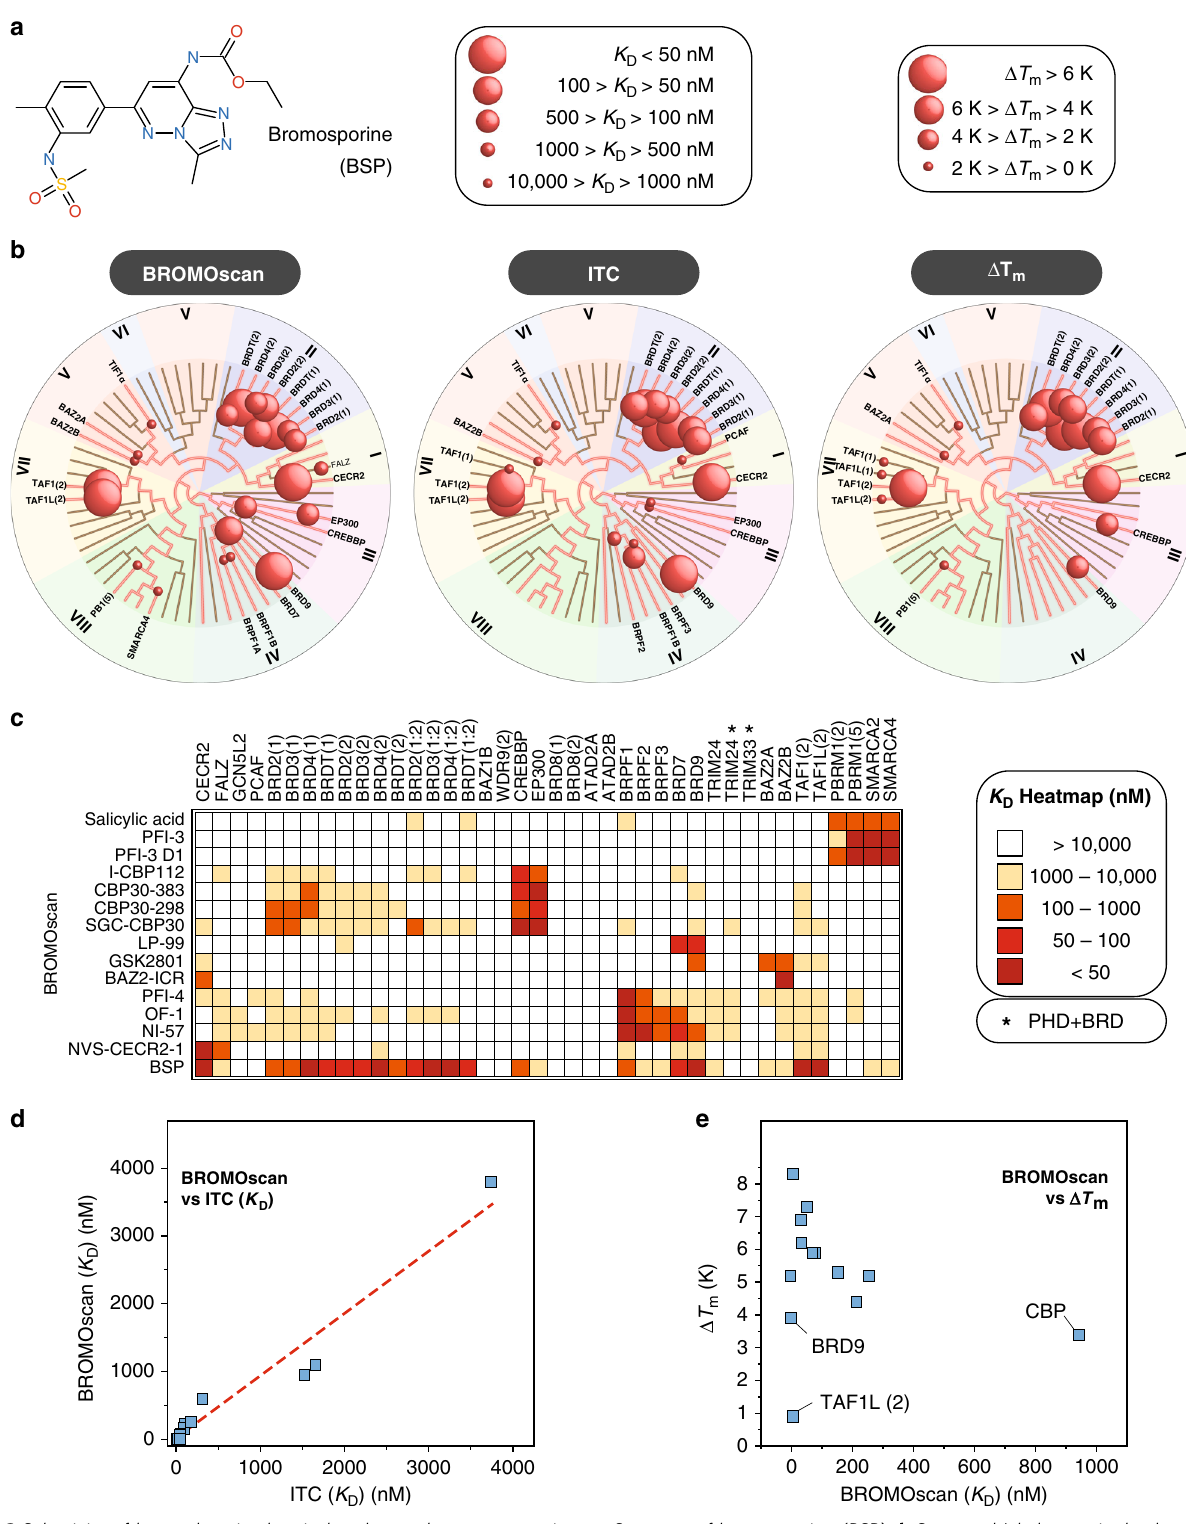
Fig. 3 Selectivity of bromodomain chemical probes and assay comparison. a Structure of bromosporine (BSP). b Structural/phylogenetic dendrograms quantifying binding af fi nities of BSP to human BRDs measured by BROMO scan (left), ITC (middle) and T m assays (right). Af fi nities and T m shifts are mapped to the phylogenetic tree using spheres of variable sizes as indicated in the inset. Screened targets are annotated on the dendrograms. c Heatmap of measured BROMO scan K D values calculated from 10-data point dose – response curves. d Correlation of dissociation constants ( K D ) measured by ITC and BROMO scan . e Correlation of T m shifts and dissociation constants ( K D ) measured by BROMO scan